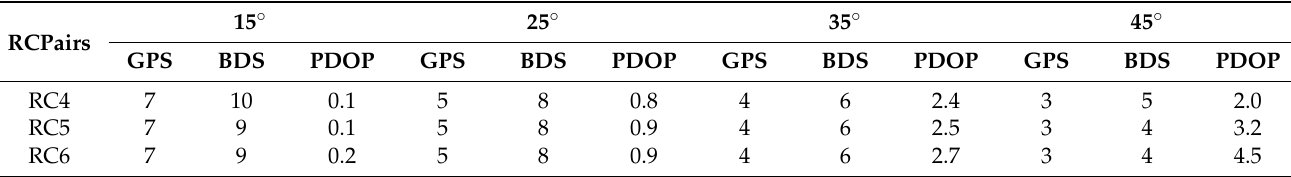
Table 7. Mean of the PDOP and satellite number with different cutoff elevation